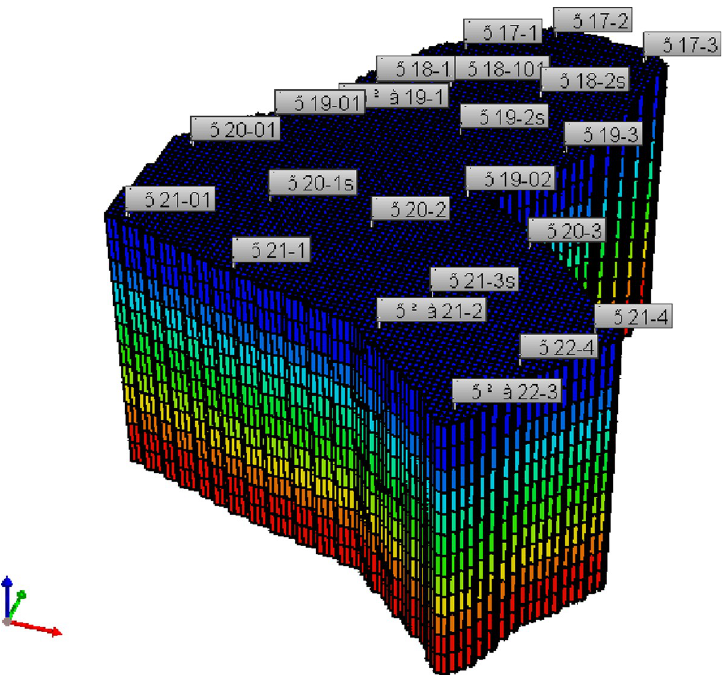
Fig 6. Conceptual geological